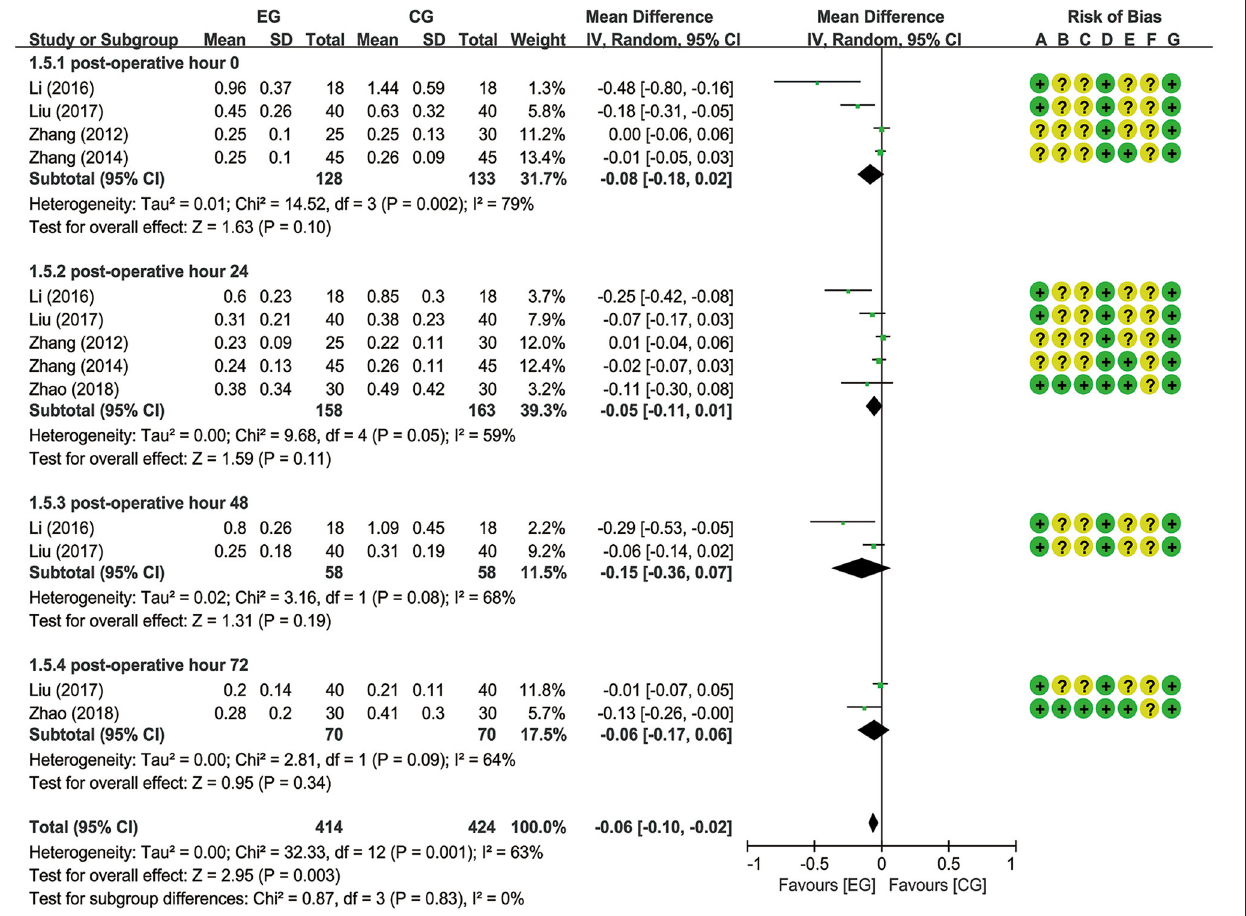
FIGURE 6 | Meta-analysis and forest plot and for S100 β at different